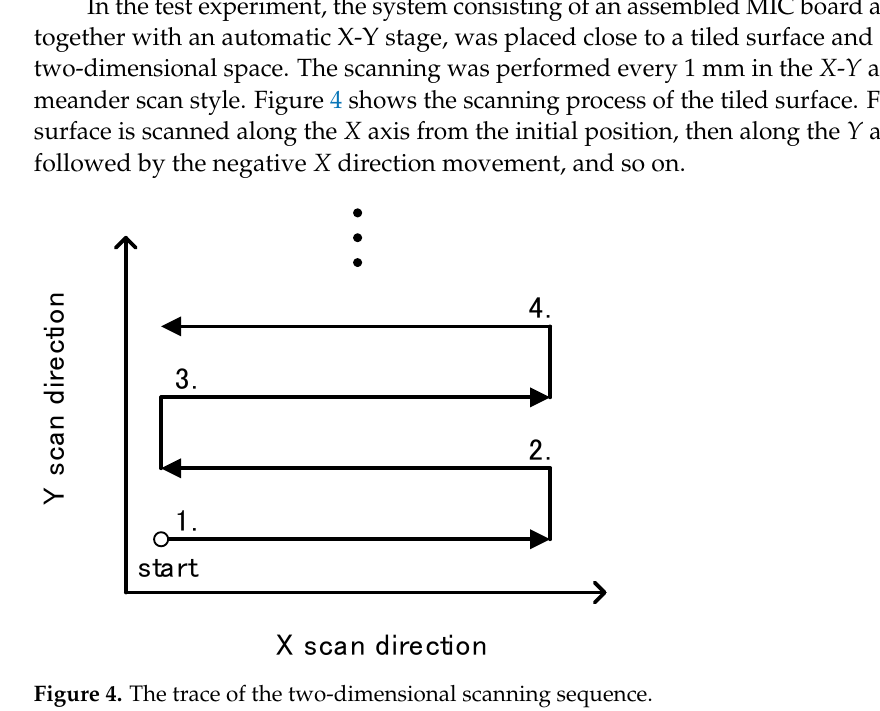
Figure 3. ( a ) Schematic of the prototype system; ( b ) picture of the transmitting and receiving antennas.